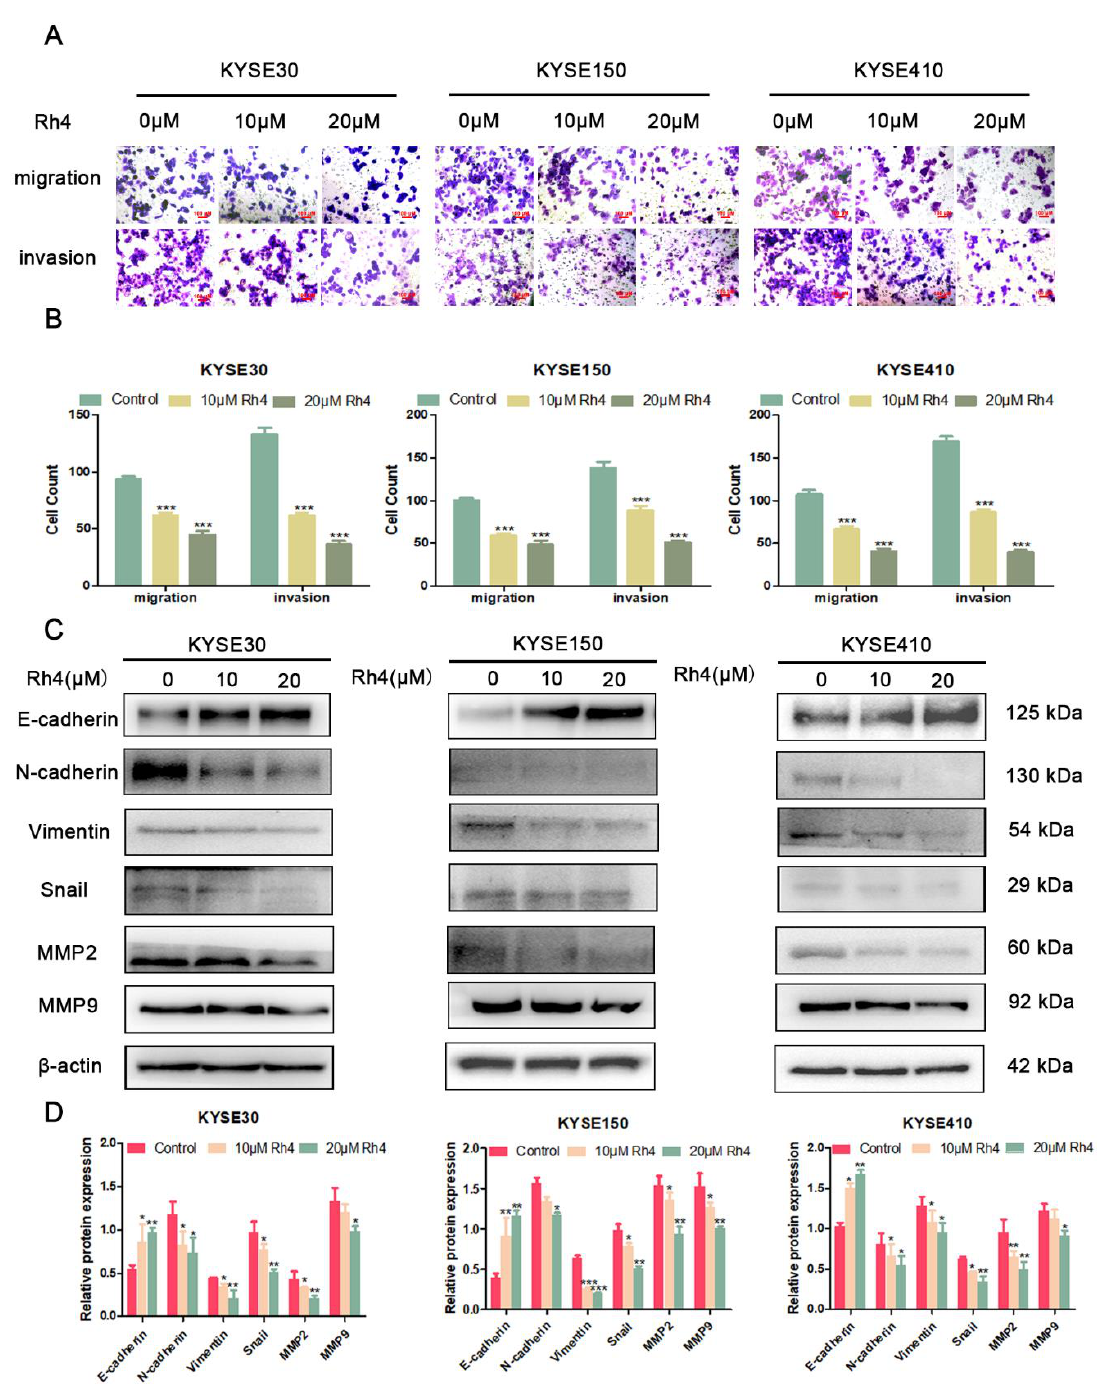
Figure 2. ( A ) Migration and invasion images of KYSE30, KYSE150, and KYSE410 cells. ( B ) Counting cells after crystal violet staining ( C , D ) Protein level of E-cadherin, N-cadherin, Vimentin, snail, MMP2, and MMP9 in KYSE30, KYSE150, and KYSE410 after Rh4 treatment (10 and 20 µM). All data are presented as mean ± SD, * p < 0.05, ** p < 0.01, and *** p < 0.001. 3.2. Ginsenoside Rh4 Inhibits the Metastasis of ESCC by Regulating EMT As previously reported, EMT is involved in the metastasis of multiple cancers [30]. Therefore, to study if Rh4 inhibits the metastasis of ESCC by regulating EMT, we detected the expression of KYSE30, KYSE150, and KYSE410 related proteins including E-cadherin,